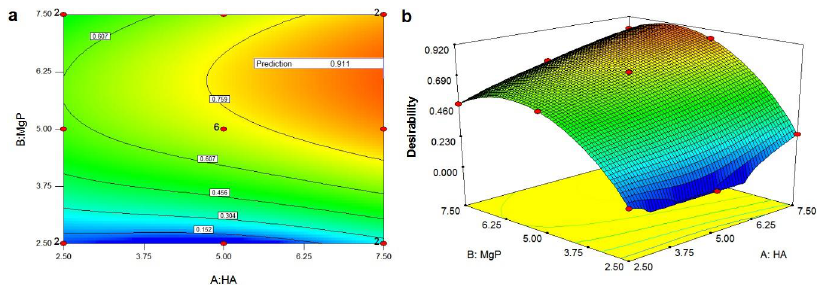
Figure 7. Overall desirability function: ( a ) contour plots and ( b ) 3D plots. (Note: The optimum region is in the red area of the graph, which has an overall desirability value of 0.911.)